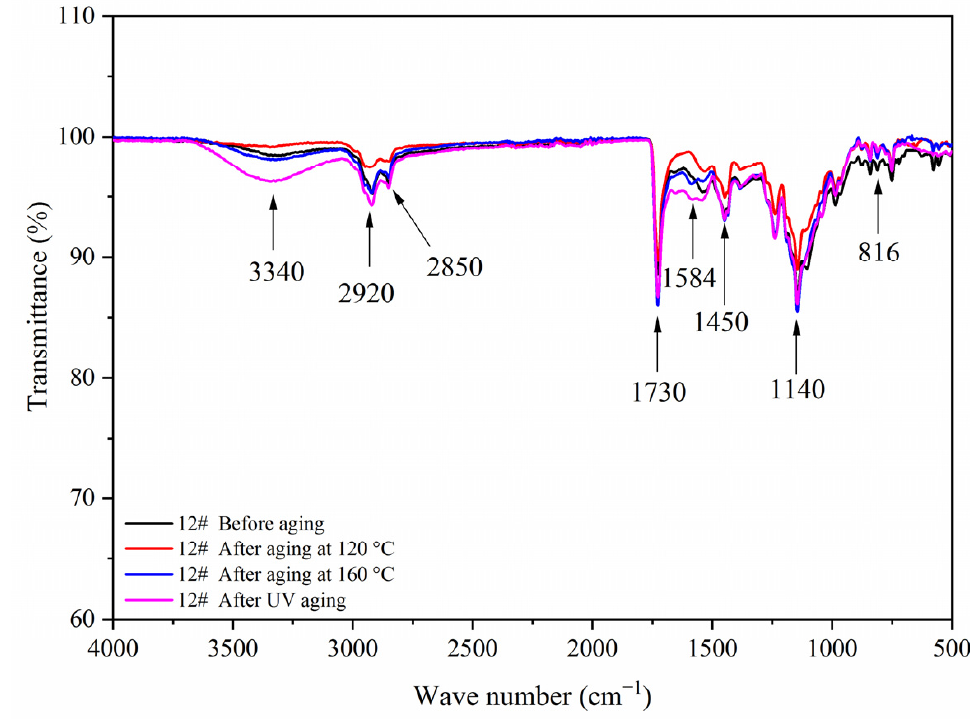
Figure 20. FTIR of sample 12# before and after aging.